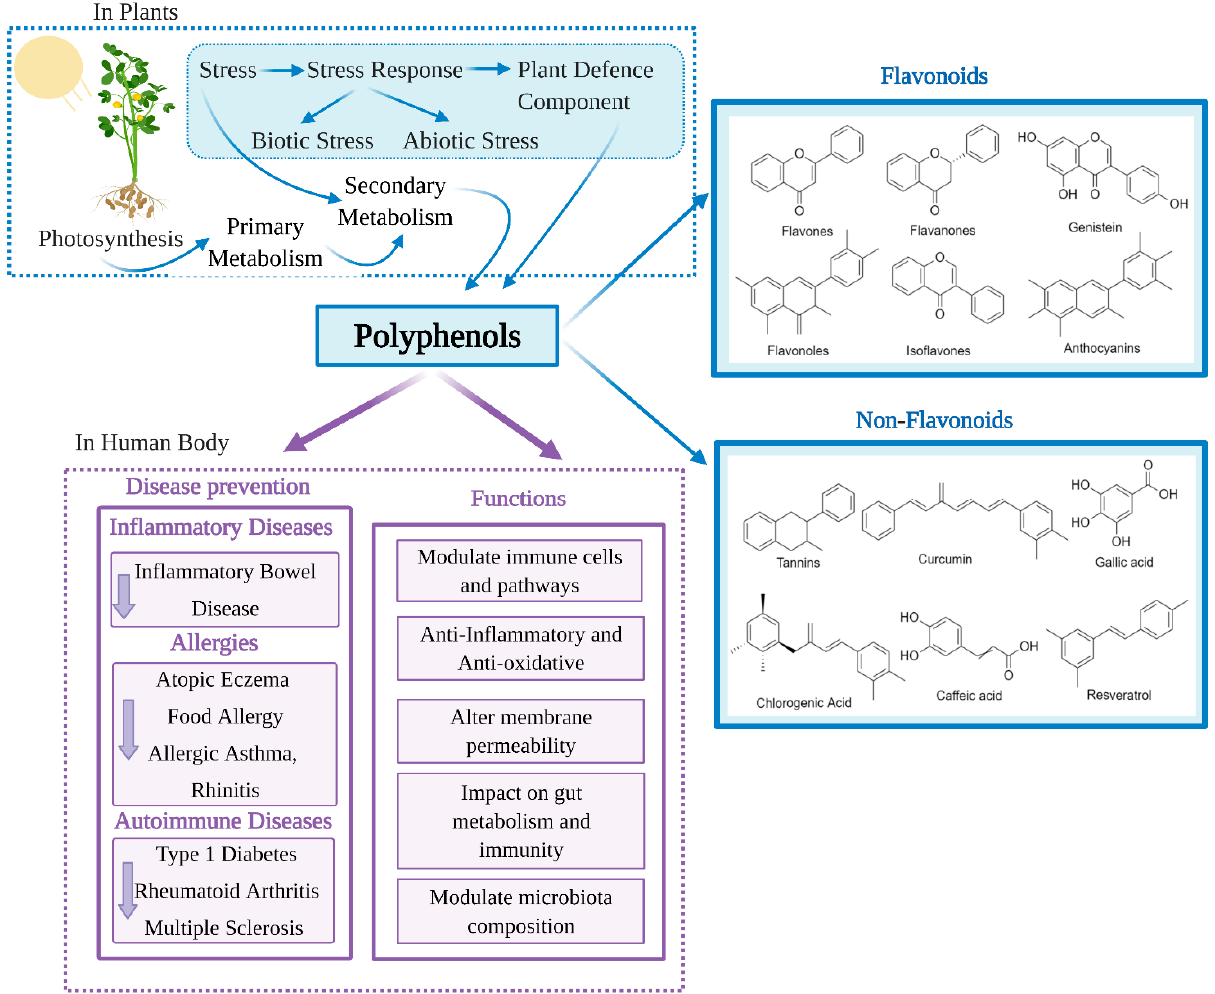
Figure 1. Classification and health benefits of polyphenols.